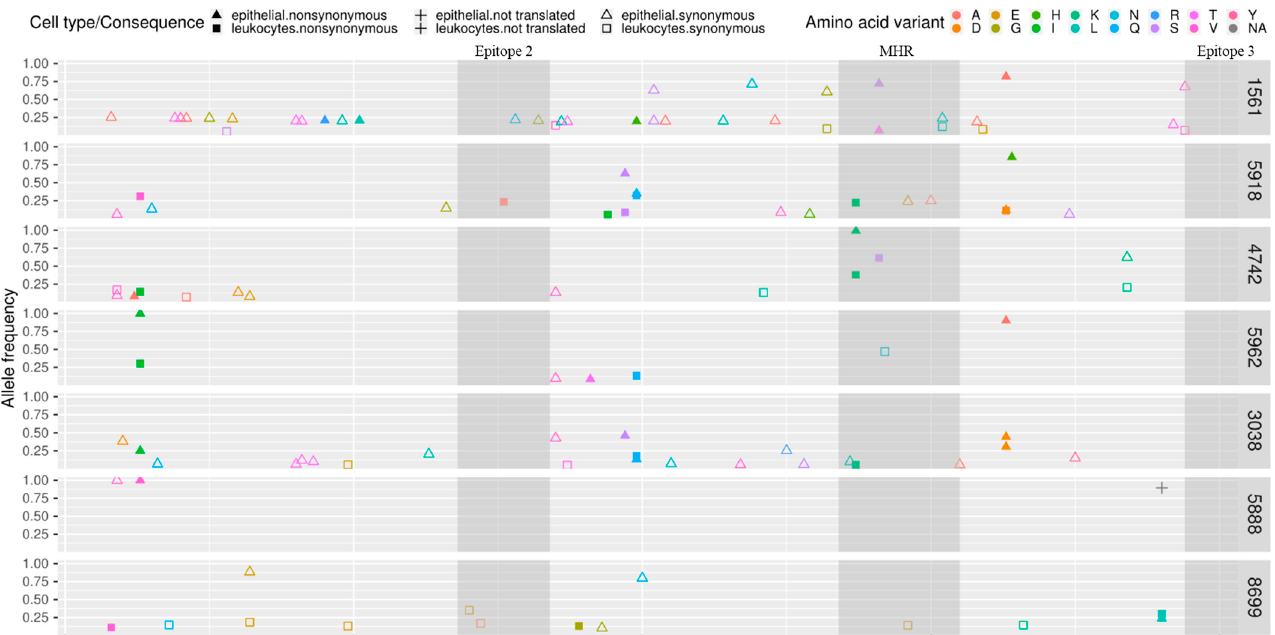
Figure 3. Distribution of single nucleotide variants (SNVs) in SRLVs gag genesequences encoding capsid protein derived from PBLs and milk epithelial cells (MEC) of goats analyzed in this study. The blue dotted lines indicate the hot spot mutations, where the number of SNVs was ≥ 4.